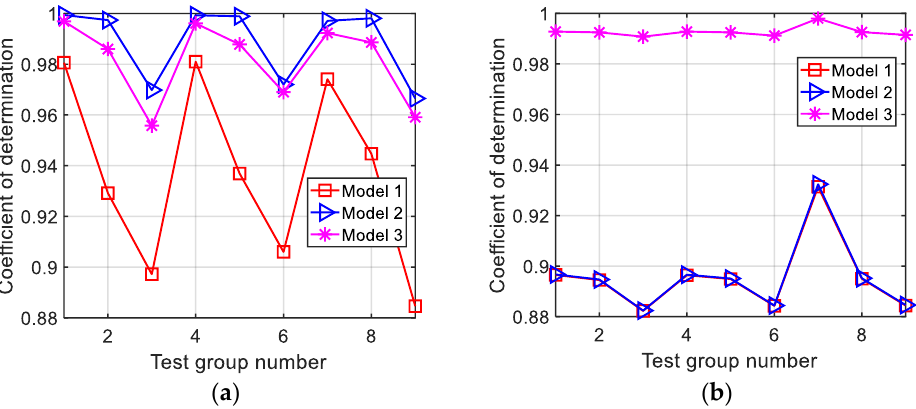
Figure 8. Accuracy comparison of three feasible form models: ( a ) Dynamic load; ( b ) speed drop.